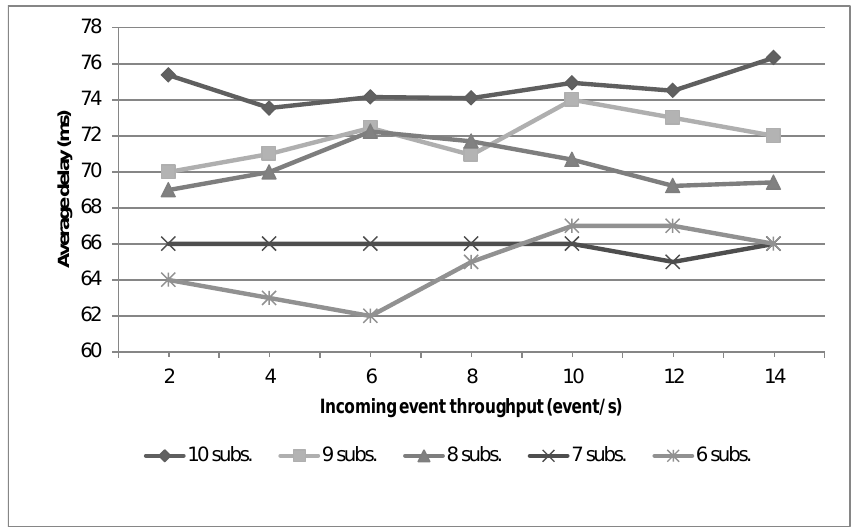
Figure 15. Average delay for every tests case in the second battery of tests.